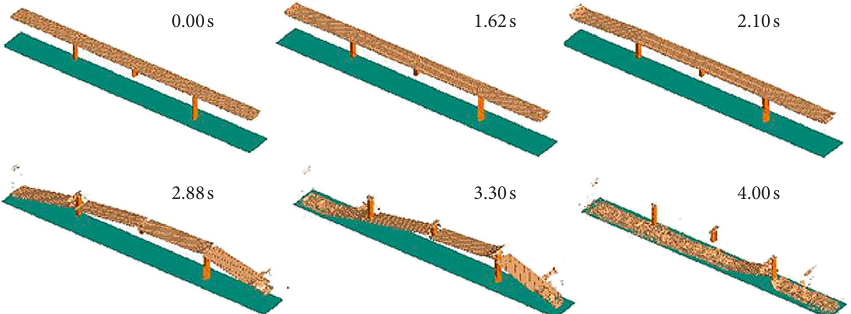
Figure 9: Collapse procedure of B213 bridge in the case of nonlinear deck in AEM, according to the current